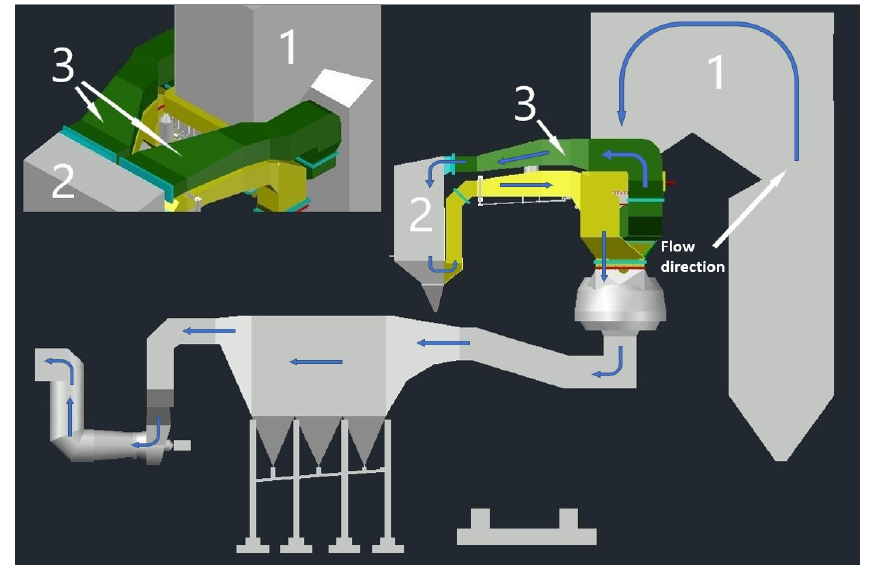
Figure 1. The analyzed boiler unit schematic with the key components: 1—boiler outline, 2—SCR installation, 3—analyzed duct